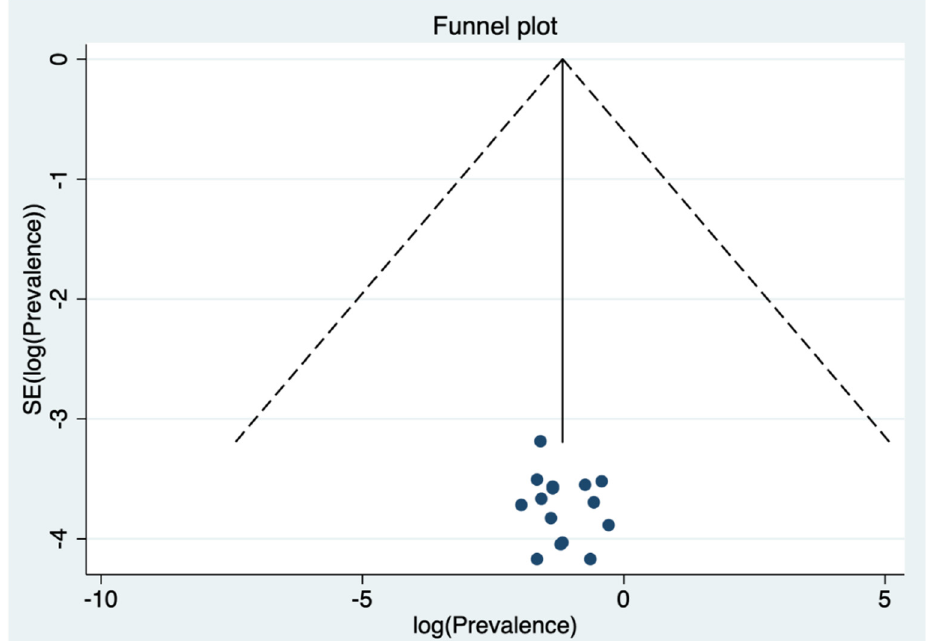
Figure 2. Forest plot for the prevalence of anxiety in dental students.